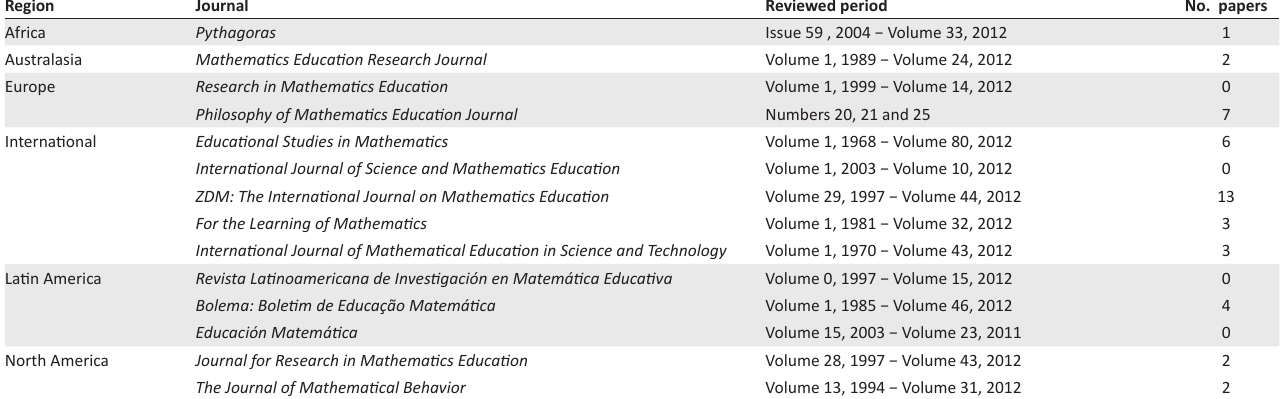
TABLE 1: Overview of the references consulted for the development of the literature review: Layer 1 − Journals.